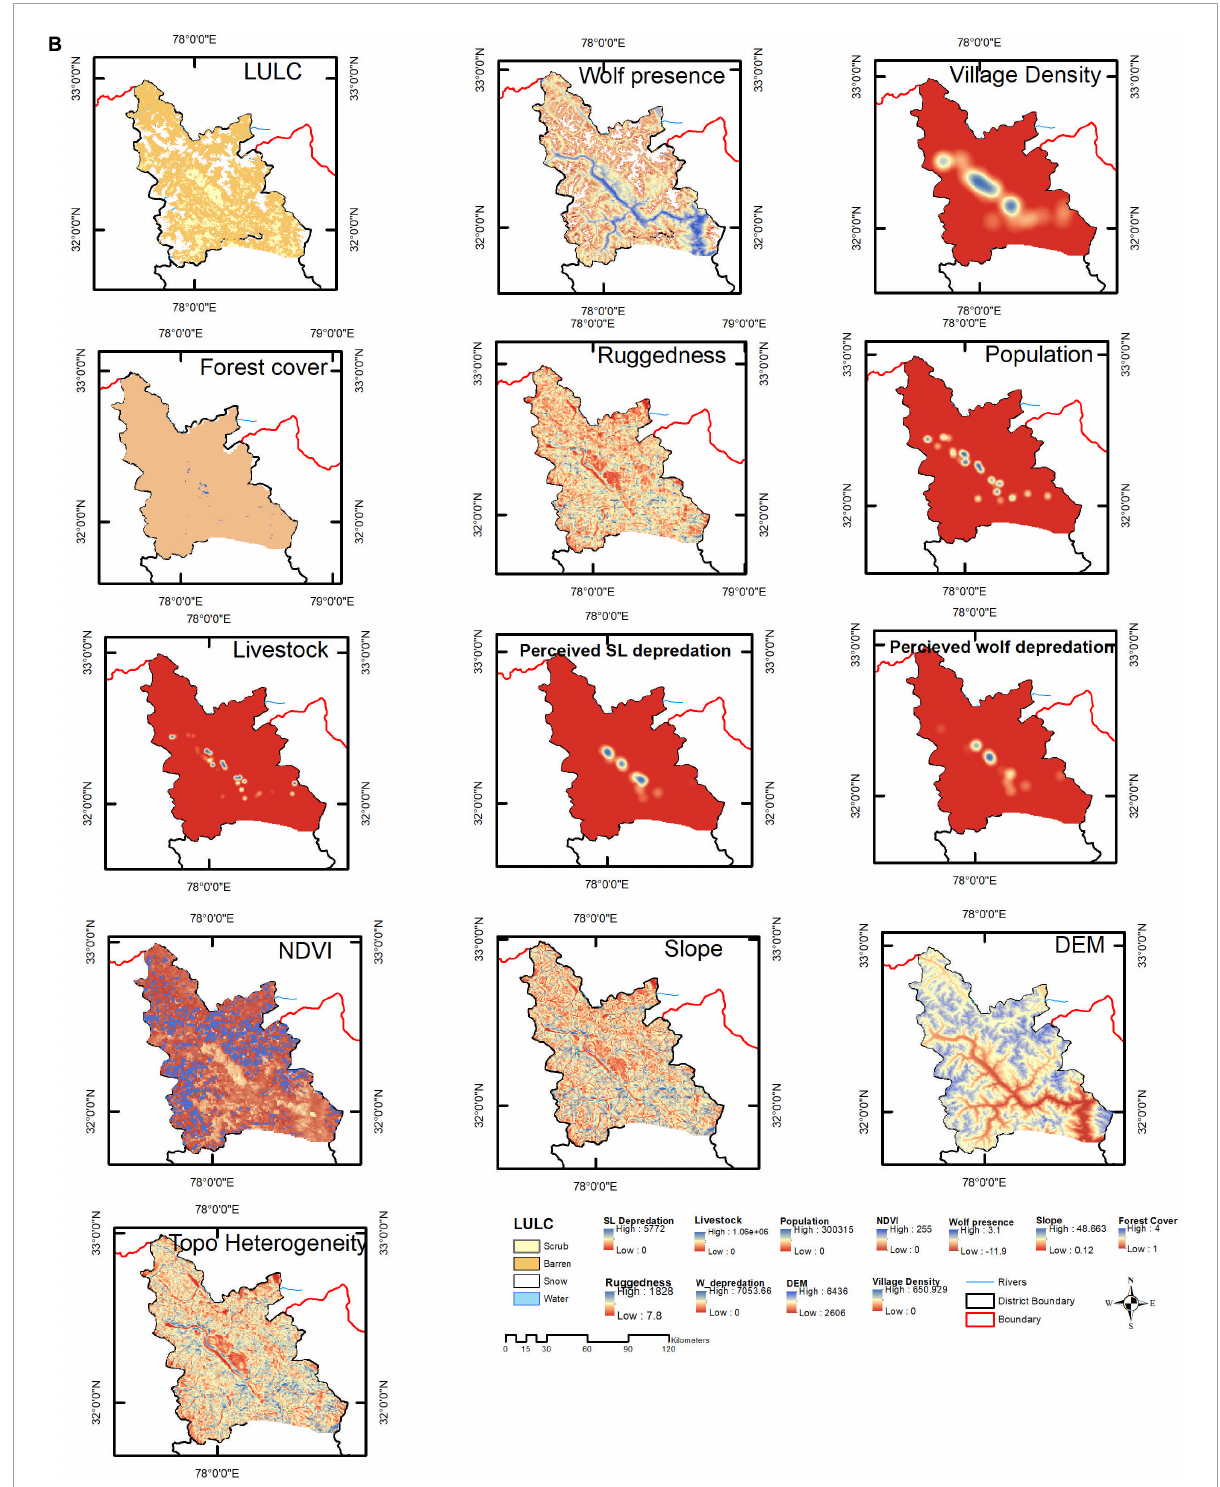
FIGURE1 (A) Study area depicting Spiti Valley with locations of scats and villages. (B) Layers used in modeling wolf conflict hotspot in MaxEnt. A total of 11 covariate layers were used. Perceived snow leopard depredation and topographic heterogeneity were dropped however included in this composite figure. Higher values are indicated by